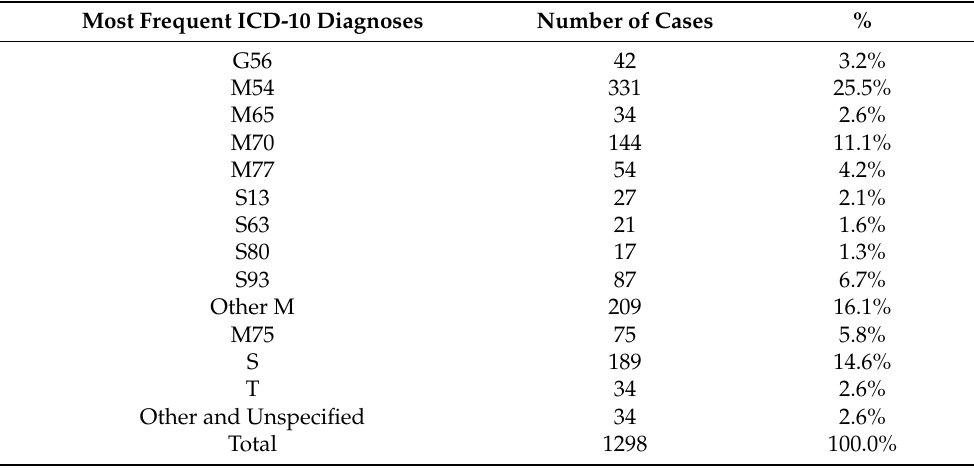
Table 2. The table presents the most frequent diagnoses made in the